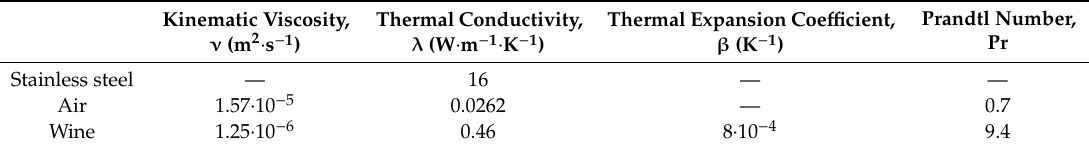
Table 1. Thermo-physical properties of the various materials, with Pr defined as the ratio of kinematic viscosity to thermal di ff